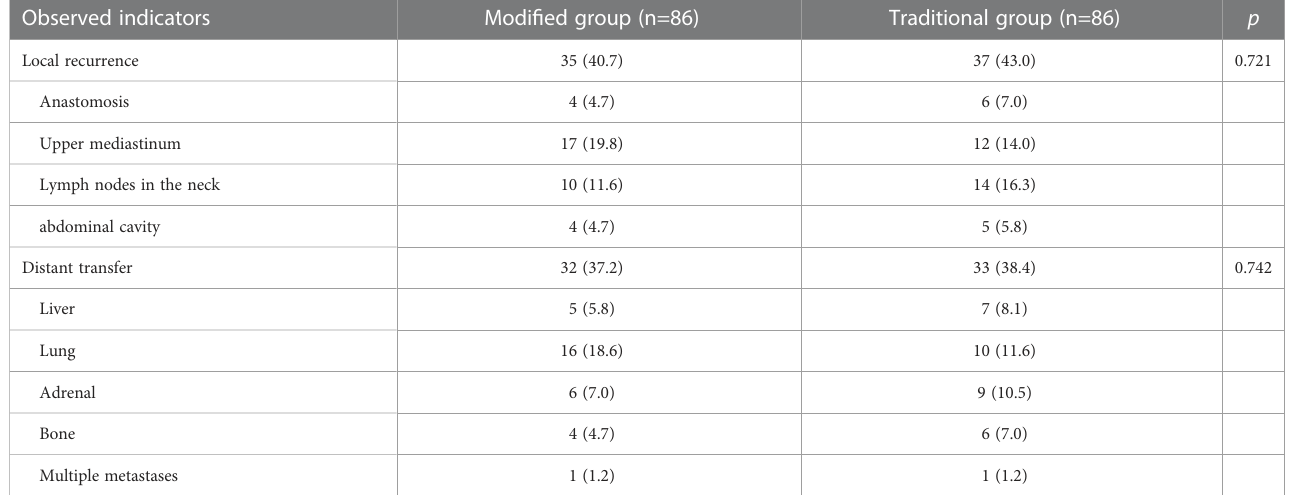
TABLE 3 Recurrence and metastasis results in both